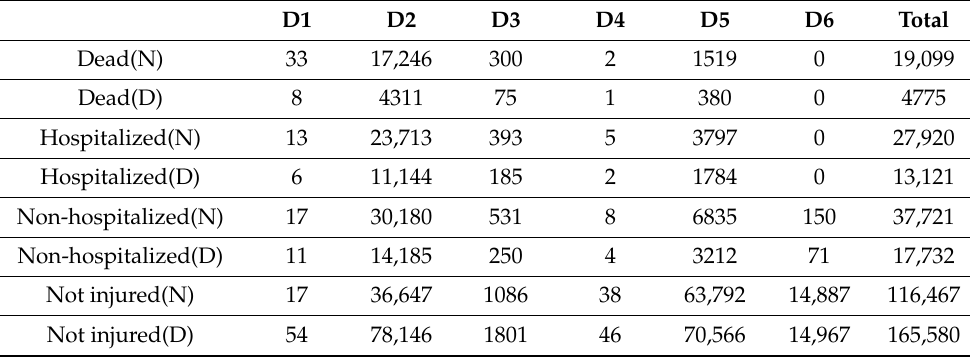
Table 11. Number of casualties in the 1721 earthquake in District 2 of Tabriz.